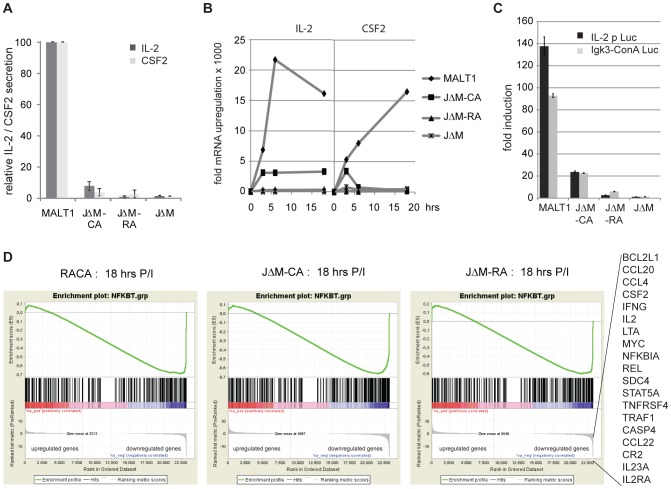
MALT1 auto-proteolysis is required for NF-κB transcriptional activity in Jurkat T cells.A) Relative IL-2 and CSF2 production of indicated Jurkat T cell lines, stimulated for 18 hrs with PMA hrs with PMA/ionomycin, measured via ELISA. Data shown as mean +/- S.D. (n = 3). B) Jurkat T cells expressing MALT1 and the JΔM-CA, JΔM-RA, and JΔM cells were stimulated for the indicated times with P/I and IL-2 and CSF2 transcript levels were determined via qRT-PCR. C) Jurkat T cells with ectopic expression of MALT1 and JΔM-CA, JΔM-RA and JΔM were electroporated (Amaxa, Nucleofection) with Luciferase reporter constructs driven by the IL-2 promoter or the Igκ3-ConA promoter, and 24 hrs later stimulated with P hrs later stimulated with P/I for 18 hrs before Luciferase activity was measured. Data shown as mean +/- S.D. (n = 3). D) GSEA showing a significant enrichment of NF-κB-target genes (FDR q<0,001) in the pre-ranked down-regulated genes from JΔM-CA, JΔM-RA and RACA cells stimulated for 18 hrs with P hrs with P/I. Gene list depicted at the right side are NF-κB target genes down-regulated in JΔM-CA, JΔM-RA and RACA cells after 3 and 18 hrs stimulation with P hrs stimulation with P/I.